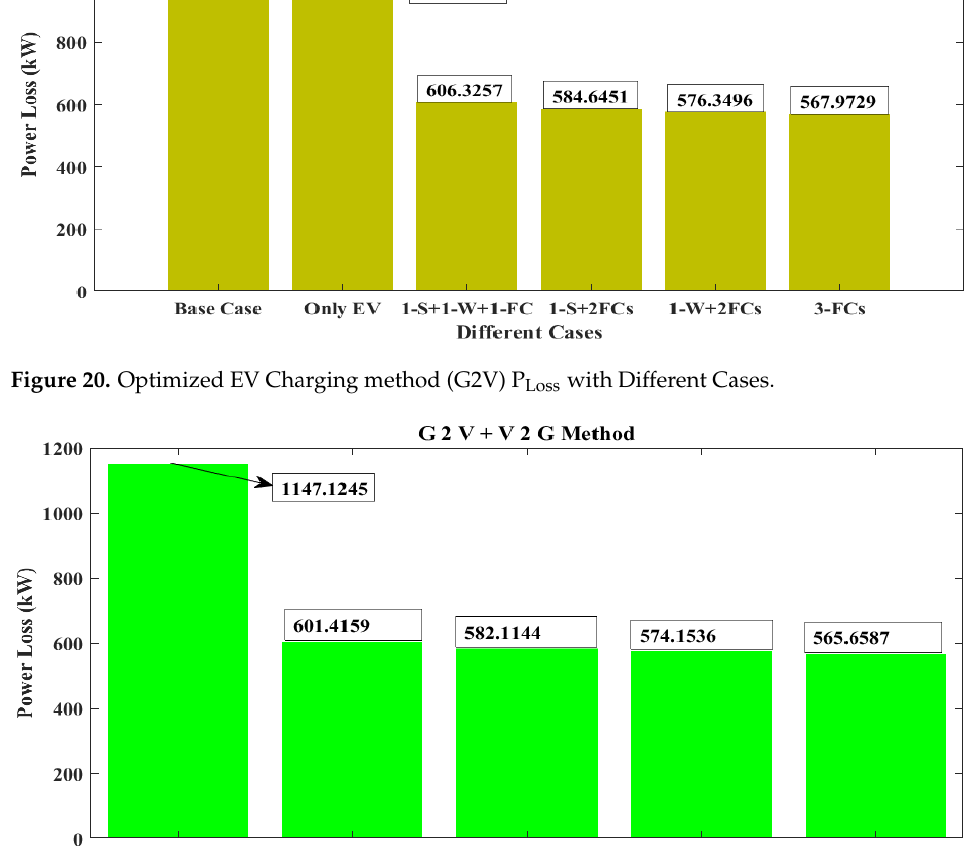
Figure 20. Optimized EV Charging method (G2V) P Loss with Different Cases.